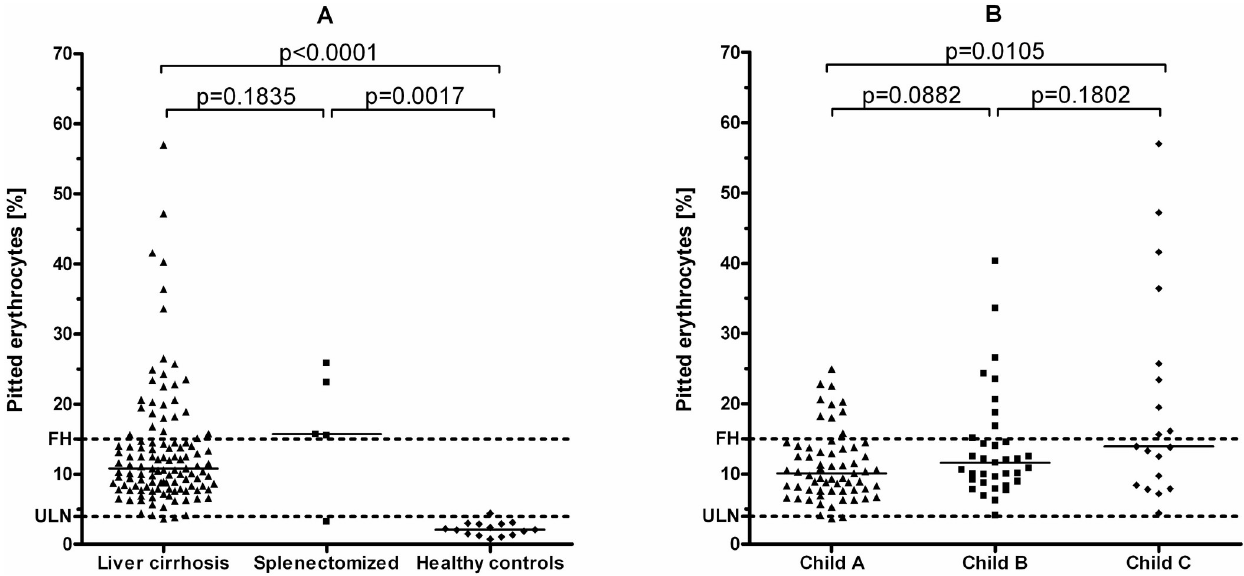
Fig 2. Comparison of pitted erythrocytes in cirrhotic patients, splenectomized patients and healthy controls (A) and between patients with Child A, B and C cirrhosis, respectively (B). The dotted lines indicate the upper limit of normal (4% pitted erythrocytes) and the threshold for diagnosis of functional hyposplenism (15% pitted erythrocytes). Results from the Mann-Whitney-U test are also shown. [ULN = upper limit of normal; FH = functional hyposplenism].